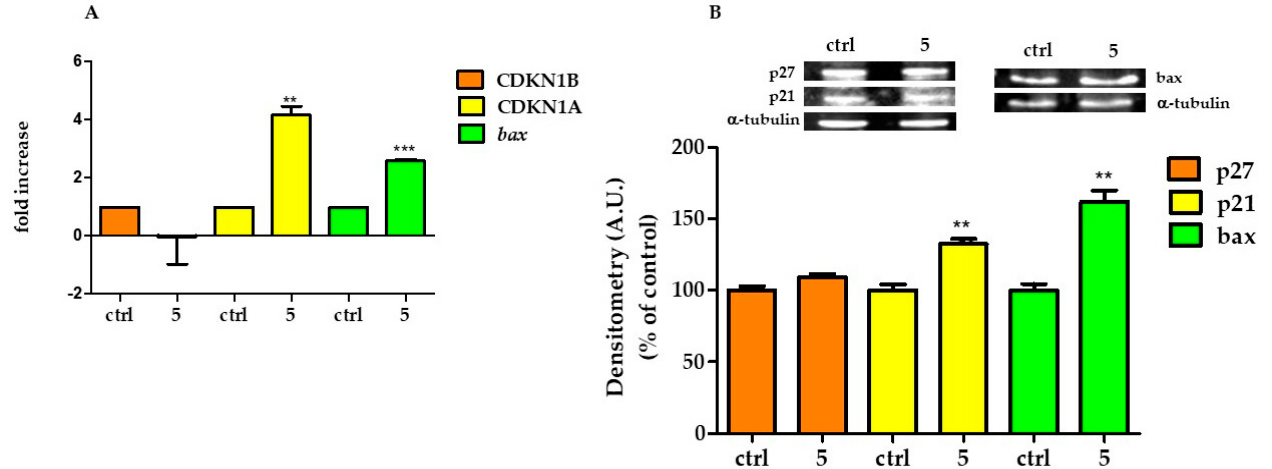
Figure 6. Modification of gene and protein expression induced by 5 . ( A ) Gene expression for CDKN1B, CDKN1A, and Bax analyzed by RT-PCR in HT29 control and treated with 5 μ M 5 for 6 h. ( B ) Above, representative western blot of p27, p21, and Bax proteins. Below, relative quantification of proteins. Densitometry arbitrary units (A.U.) were normalized by α -tubulin. Results are given as means ± SD of three independent experiments and are compared to controls, taken as 100%. (** p < 0.001; *** p < 0.0001).